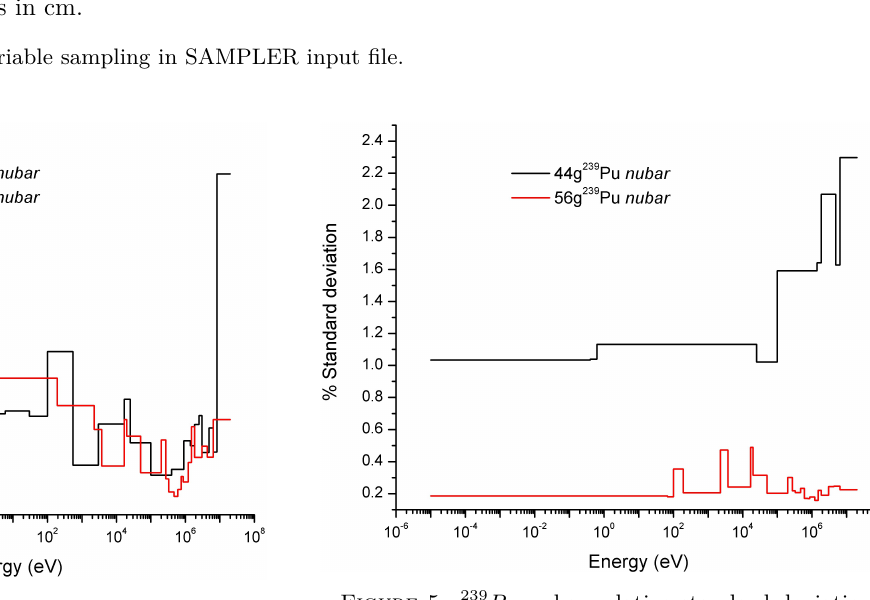
Figure 4. 235 U nubar relative standard deviation by energy for covariance libraries 44groupcov and 56groupcov.